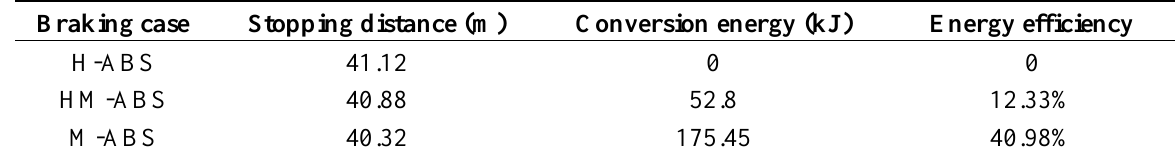
Table 4. Stopping distance and conversion energy in three